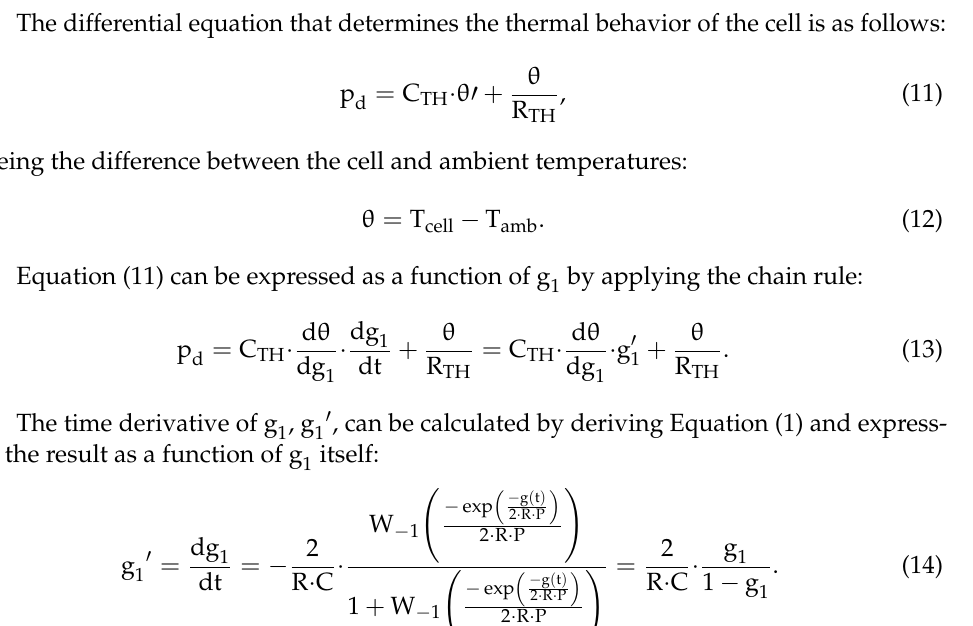
Figure 4. Thermal model of an SC based on an analogy with an electrical circuit.